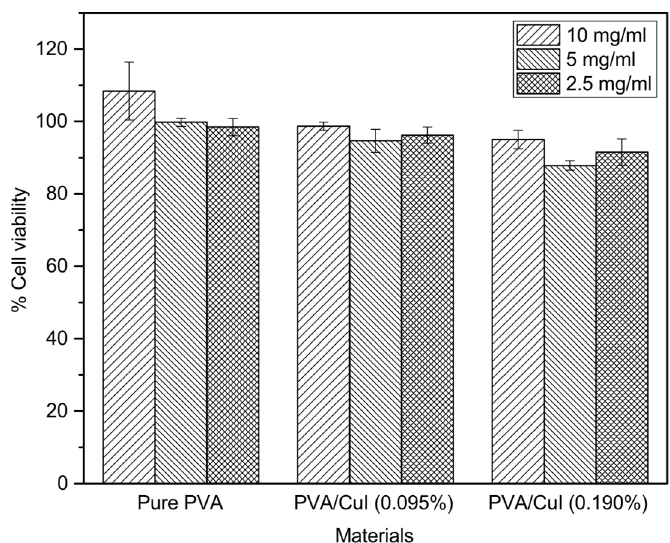
Figure 13. Water vapor transmission rate (WVTR) for each synthesized liquid bandage.